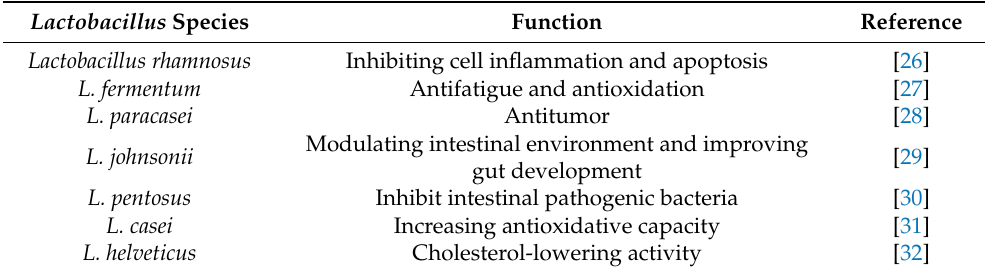
Table 1. Probiotic function of Lactobacillus